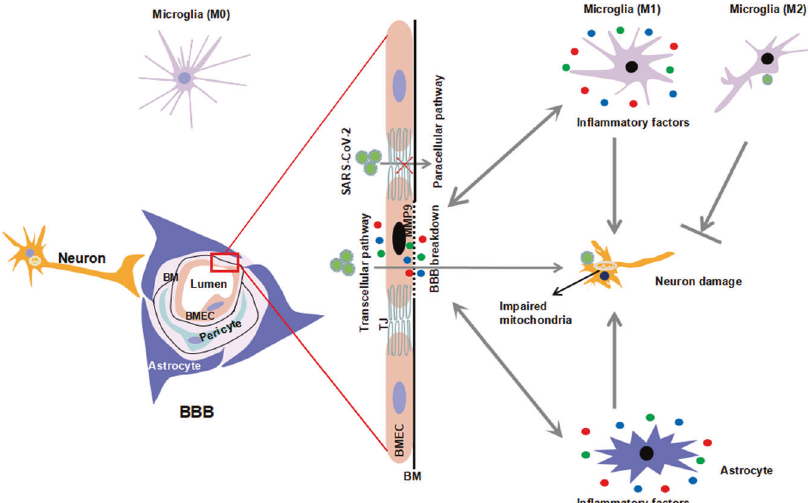
diffusion of substances and pathogens. During infection, SARS-CoV-2 can infect the BMECs and cross the BBB to the brain via transcellular pathway by MMP9-mediated basement membrane (BM) disruption rather than a paracellular pathway. Neurons are relatively vulnerable to SARS-CoV-2 infection. Mitochondrial impairment and neuronal damage exist after infection accompanied by an in fl ammatory response, including activation of microglia/astrocytes and production of in fl ammatory factors. Further, the in fl ammatory factors produced by activated microglia, astrocytes and BMECs, in turn, exacerbate the damage of the BBB and neuronal